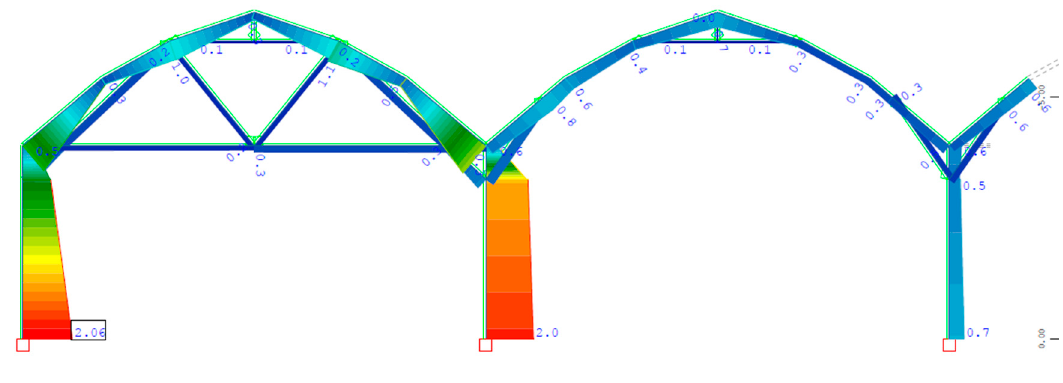
Figure 17. The ratio of design bending moment to design bending resistance of the cross-section, M yed /M yRd , of columns of the vaulted greenhouse.